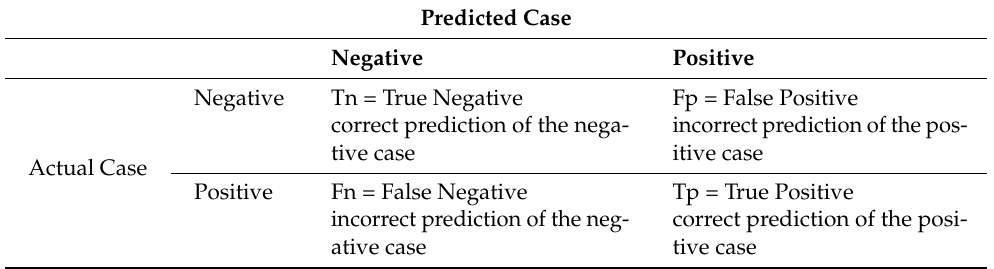
Table 2. Confusion